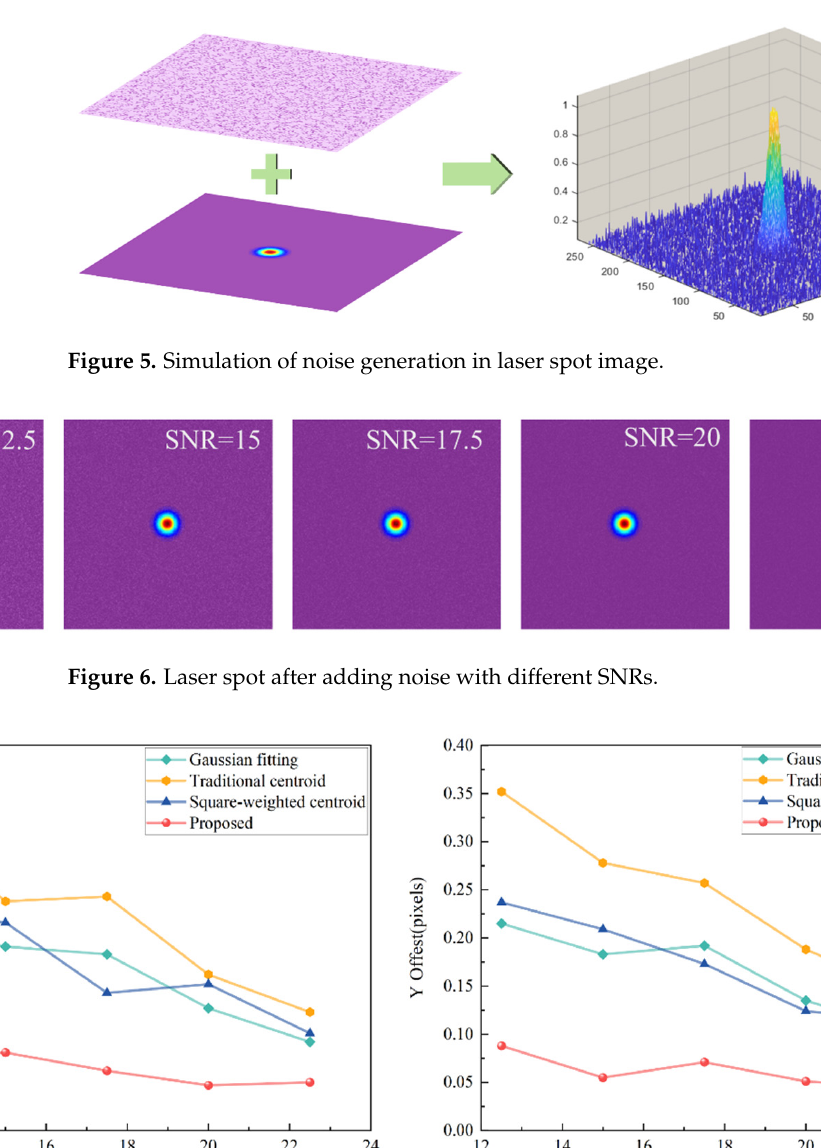
Figure 8. Iterative convergence process of spot area.